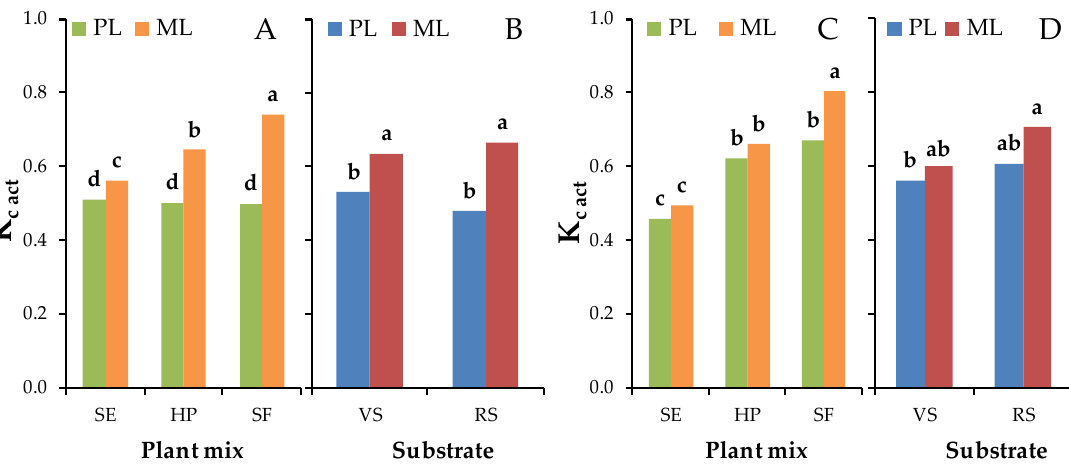
Figure 11. Interaction effect of plant mix × drainage/storage layer and substrate × drainage/storage layer in April 2016 ( A , B , respectively) and June 2016 ( C , D , respectively) on the actual crop coefficient (K c act ). Histogram values with different letters indicate significant differences according to Tukey’s HSD test ( p < 0.05).